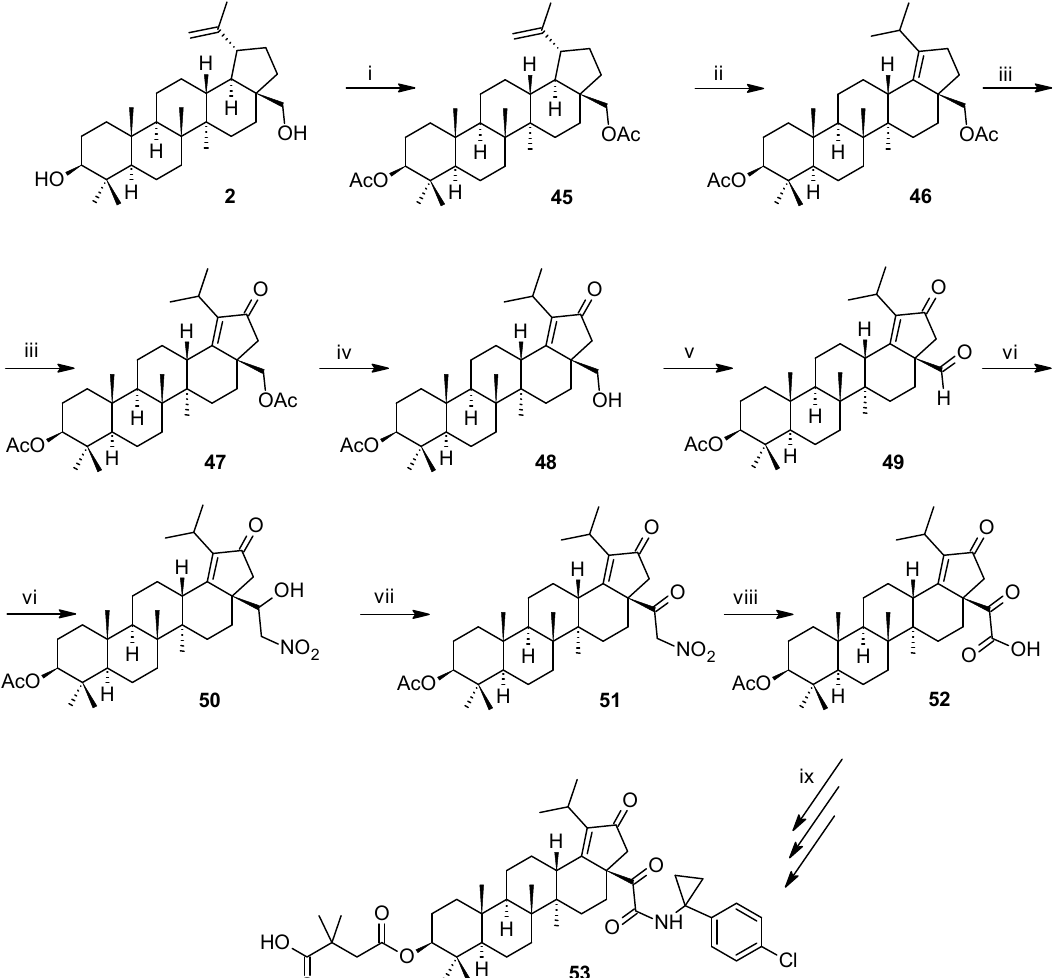
Table 2. iii : Na 2 Cr 2 O 7 , NaOAc, toluene, AcOH, Ac 2 O, iv : KOH, toluene, ethanol, v : PCC, silica gel, DCM, vi : CH 3 NO 2 , triethylamine, vii : DMP, DCM, viii : NaNO 2 , AcOH, DMSO, ix : ( a ) oxalyl